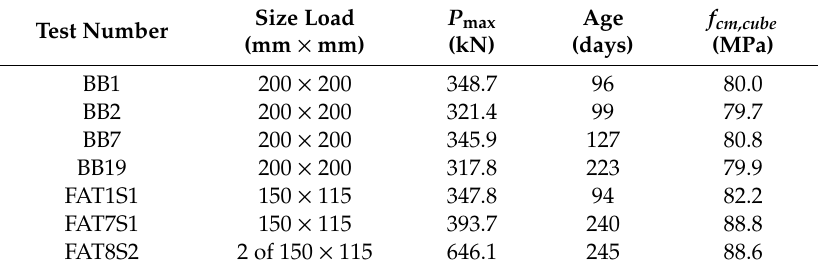
Table 2. Overview of the static tests used for assessment of the case study bridge.